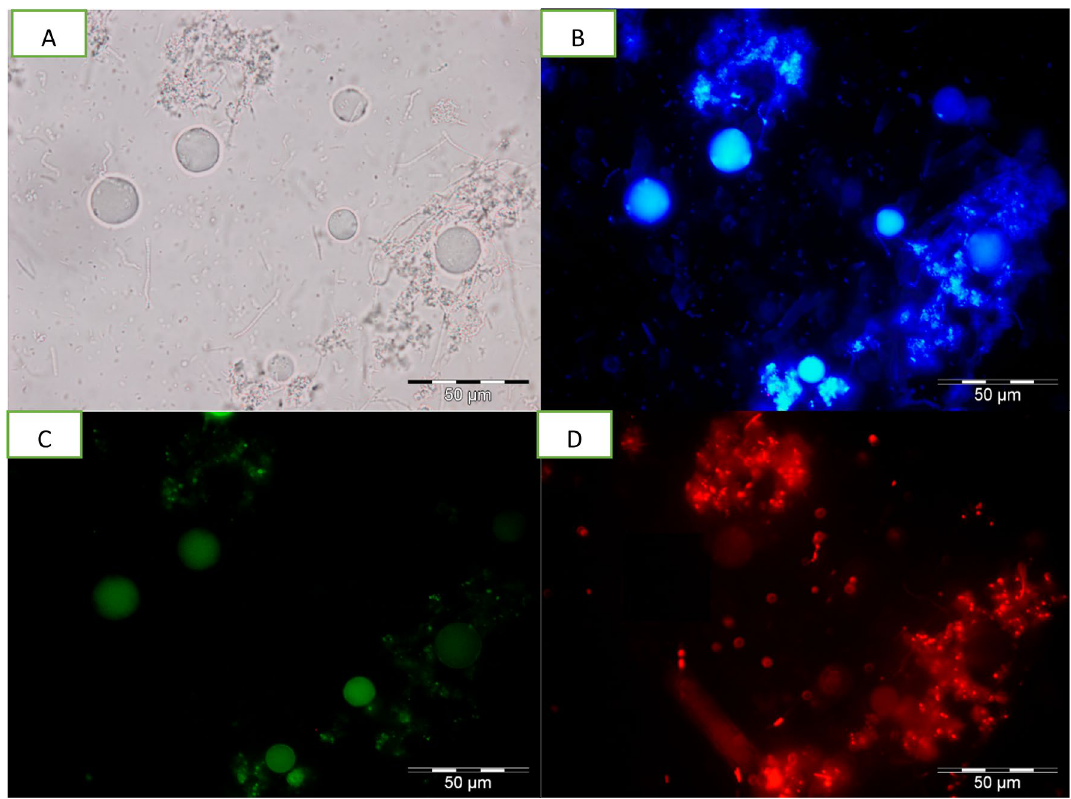
Figure 5. Images of untreated Blastocystis sp. undergoing apoptosis viewed under epifluorescent microscope; ( A ) Bright field; ( B ) stained using Hoechst stain; ( C ) stained using FITC Annexin (V); ( D ) stained using Propidium